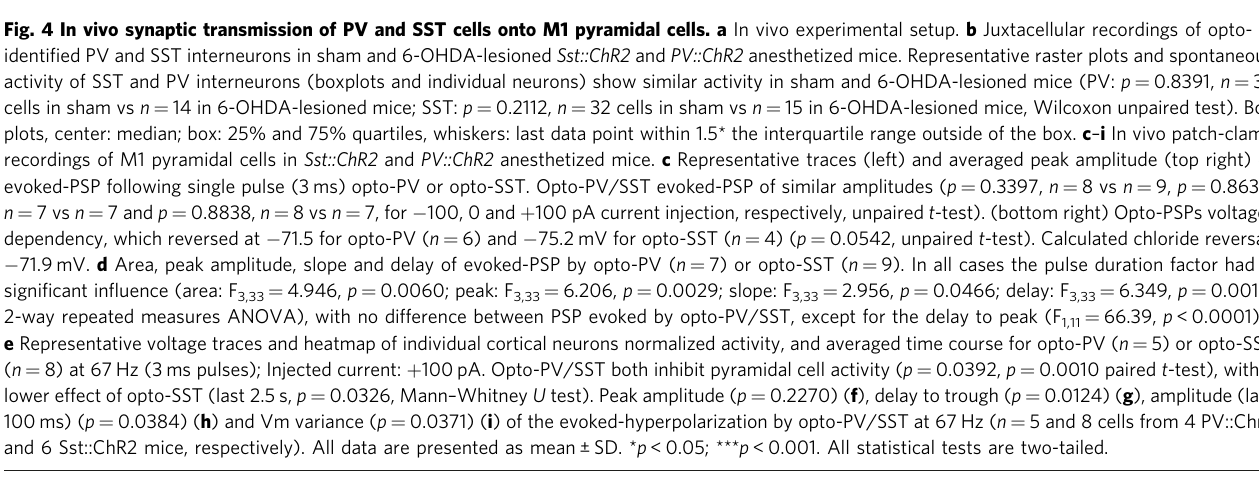
Fig. 4 In vivo synaptic transmission of PV and SST cells onto M1 pyramidal cells. a In vivo experimental setup. b Juxtacellular recordings of opto- identi fi ed PV and SST interneurons in sham and 6-OHDA-lesioned Sst::ChR2 and PV::ChR2 anesthetized mice. Representative raster plots and spontaneous activity of SST and PV interneurons (boxplots and individual neurons) show similar activity in sham and 6-OHDA-lesioned mice (PV: p = 0.8391, n = 32 cells in sham vs n = 14 in 6-OHDA-lesioned mice; SST: p = 0.2112, n = 32 cells in sham vs n = 15 in 6-OHDA-lesioned mice, Wilcoxon unpaired test). Box plots, center: median; box: 25% and 75% quartiles, whiskers: last data point within 1.5* the interquartile range outside of the box. c – i In vivo patch-clamp recordings of M1 pyramidal cells in Sst::ChR2 and PV::ChR2 anesthetized mice. c Representative traces (left) and averaged peak amplitude (top right) of evoked-PSP following single pulse (3 ms) opto-PV or opto-SST. Opto-PV/SST evoked-PSP of similar amplitudes ( p = 0.3397, n = 8 vs n = 9, p = 0.8632, n = 7 vs n = 7 and p = 0.8838, n = 8 vs n = 7, for − 100, 0 and + 100 pA current injection, respectively, unpaired t -test). (bottom right) Opto-PSPs voltage- dependency, which reversed at − 71.5 for opto-PV ( n = 6) and − 75.2 mV for opto-SST ( n = 4) ( p = 0.0542, unpaired t -test). Calculated chloride reversal: − 71.9 mV. d Area, peak amplitude, slope and delay of evoked-PSP by opto-PV ( n = 7) or opto-SST ( n = 9). In all cases the pulse duration factor had a signi fi cant in fl uence (area: F 3,33 = 4.946, p = 0.0060; peak: F 3,33 = 6.206, p = 0.0029; slope: F 3,33 = 2.956, p = 0.0466; delay: F 3,33 = 6.349, p =